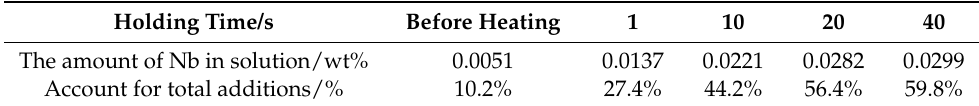
Table 2. Amounts of Nb in the solution held at 1150 ◦ C for different times.